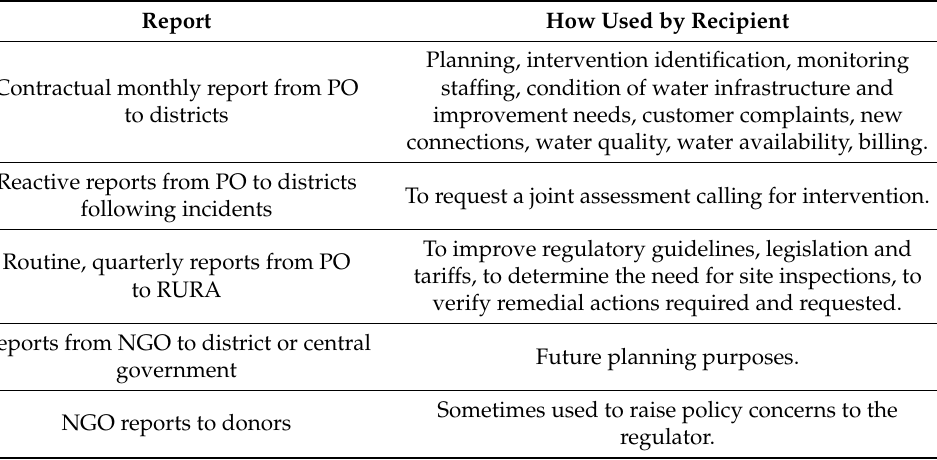
Table 3. Formal reporting mechanisms employed between drinking-water stakeholder groups in Rwanda, including how these reports are used by recipients. PO—private operator, RURA—Rwanda Utilities Regulatory Authority, NGO—non-governmental